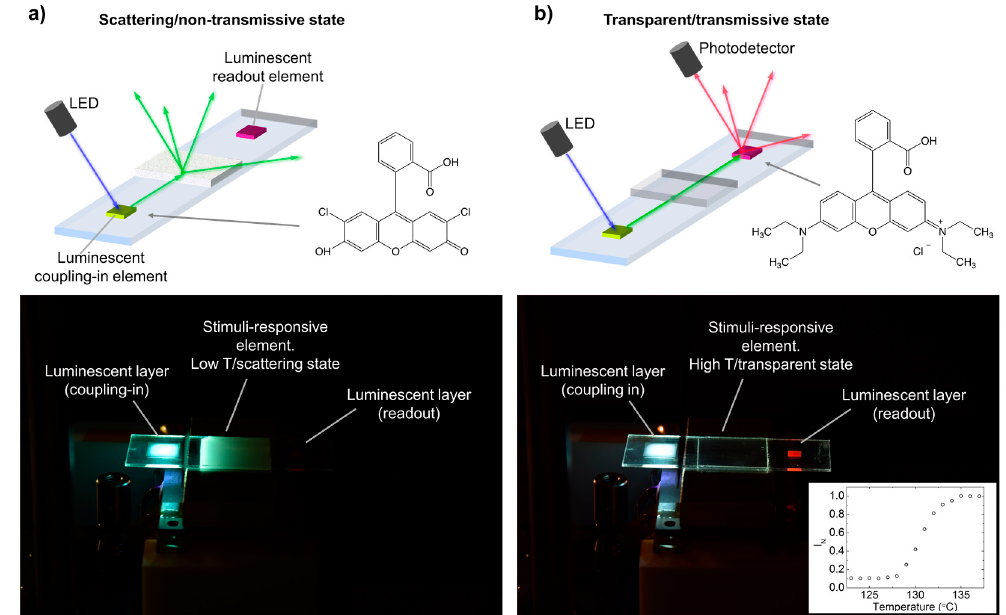
Figure 4. ( a , b ) Schematic representation (top) and photograph (bottom) of the optical planar waveguide sensor including a luminescent coupling element and a luminescent temperature readout element ( a ) in the scattering / non-transmissive state, at low temperature, and ( b ) in the transmissive state, at high temperature. Light from a UV LED (peak wavelength at 365 nm) excites from the top the photocured HRI-F27-02 layer that emits light, partly coupled in the planar waveguide and travelling towards the thermoresponsive liquid crystal polymer sensor material. Waveguided light reaching the HRI-RhodB-02 layer is partly absorbed and re-emitted as orange-red light. A photodetector measures the red light (633 nm) intensity emitted by this luminescent layer as a function of the LCP layer temperature. The molecular structures of F27 and RhodB are shown in ( a ) and ( b ), respectively. The inset in ( b ) shows a plot of the emitted red light (633 nm) measured as a function of temperature at the sensing region.